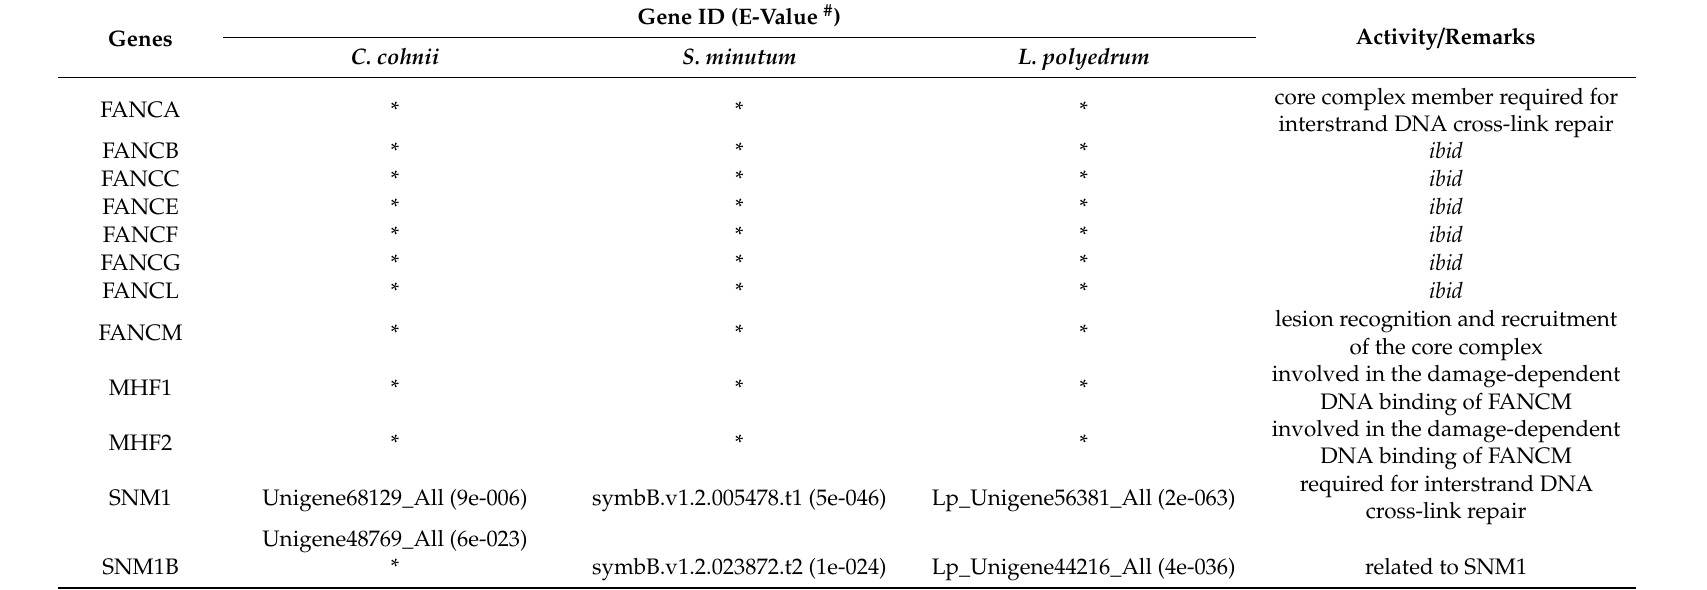
Table 9. Predicted dinoflagellate orthologues predicted in interstrand crosslinks